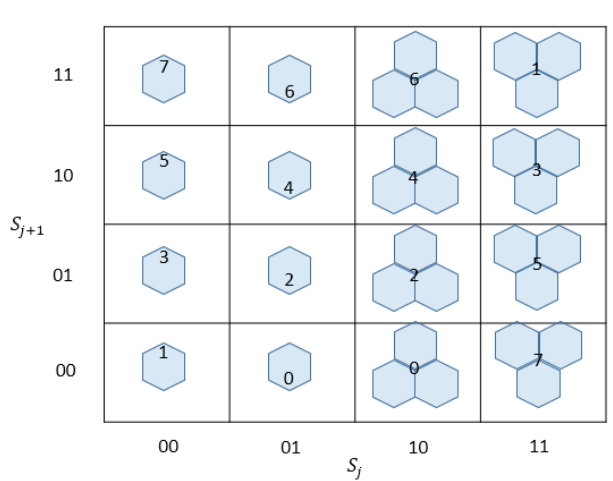
Figure 1. Turtle shell reference matrix.